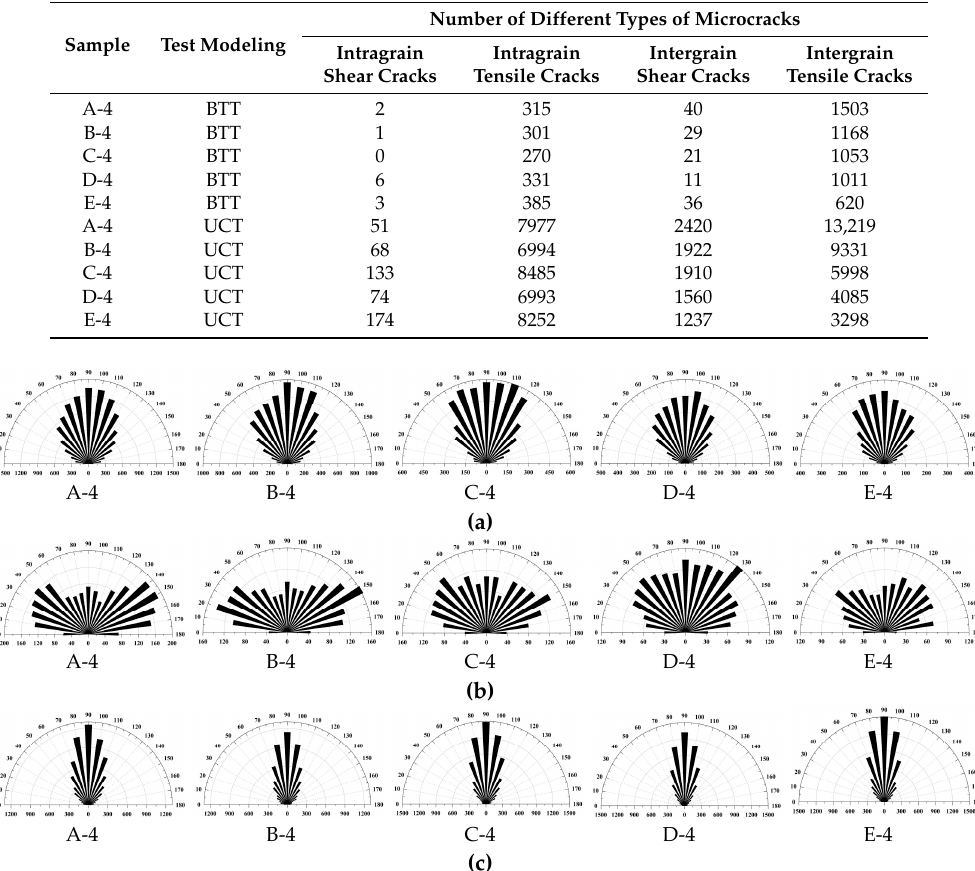
Figure 14. The rose diagrams of the inclination angle of different type microcracks in the corresponding models in Figure 13b. ( a ) The rose diagram of inclination angle of intergrain tensile